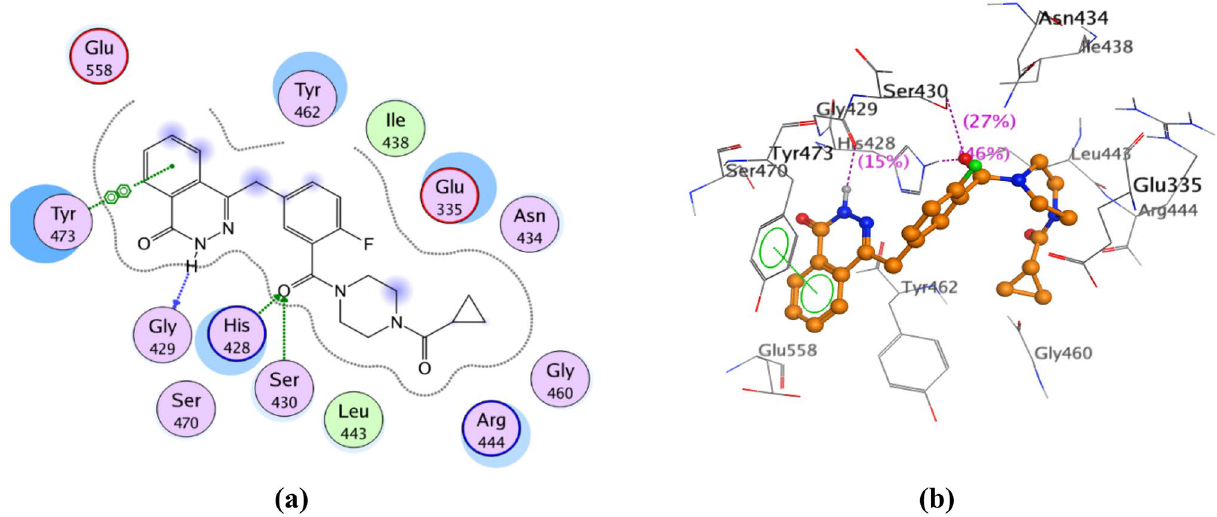
Figure 11. ( a ) 2D view of the interactions between olaparib and PARP-2 enzyme active site. ( b ) 3D view of the interactions between olaparib and PARP-2 enzyme active